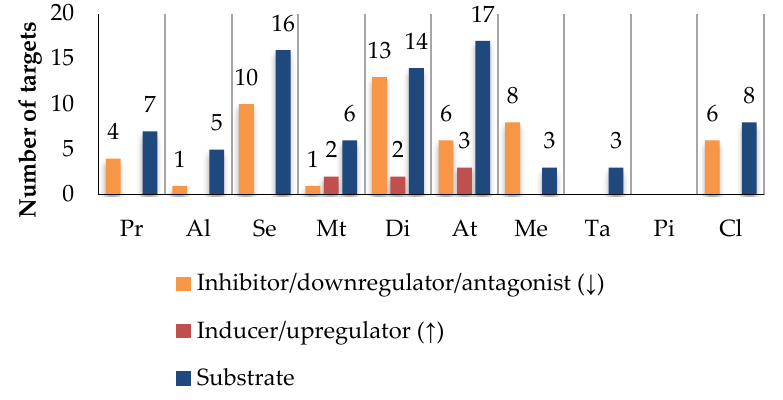
Figure 5. Effect of drugs on targets. The number of shared targets between drugs and bioactives was taken as a measure of potential interaction. Propranolol (Pr), alprazolam (Al), sertraline (Se), metformin (Mt), diclofenac (Di), atorvastatin (At), tadalafil (Ta), memantine (Me), piracetam (Pi), and clopidogrel (Cl).